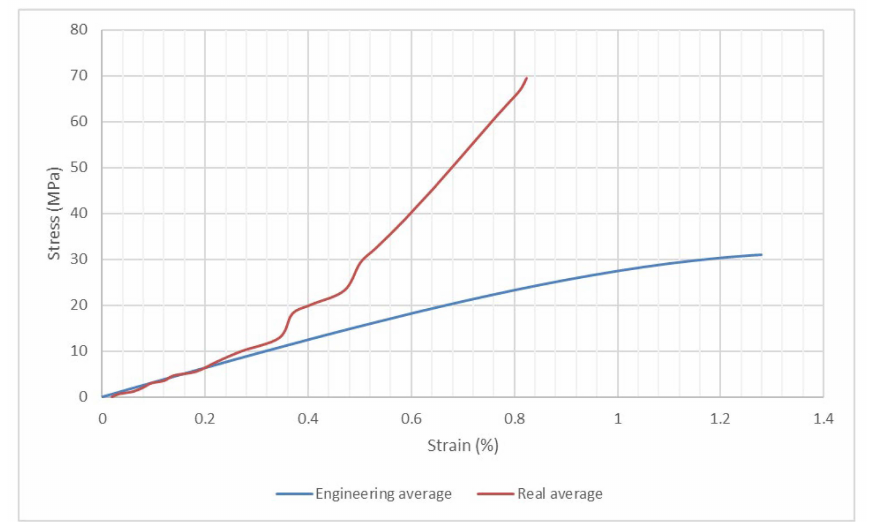
Figure 19. Comparison between the stress-strain evolution for the real values and the engineering